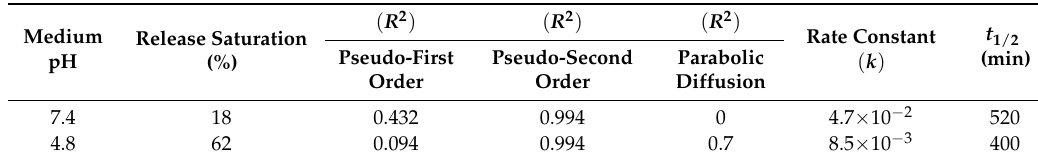
Table 1. Fitted data of correlation coefficients ( R 2 ), rate constants ( k ), and half-lives ( t 1/2 ) of gallic acid released from GAGZA at pH 7.4 and 4.8.